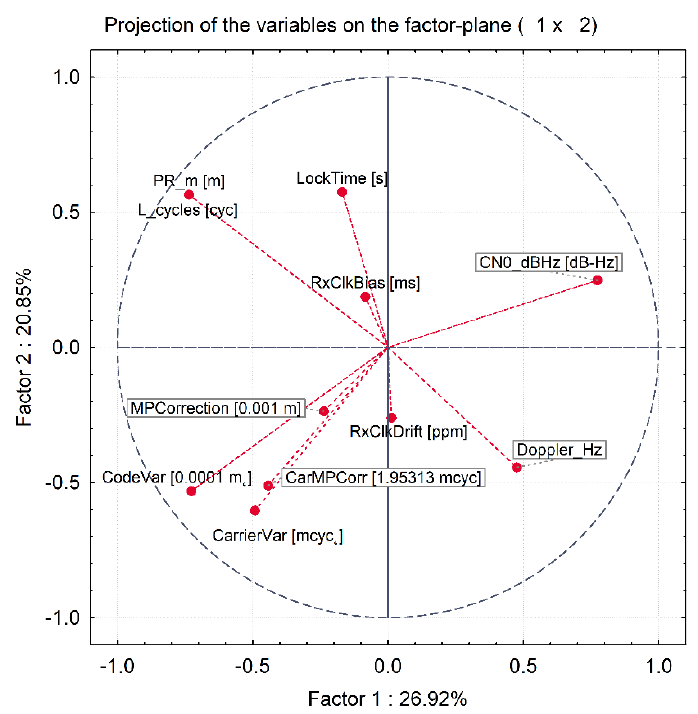
Figure 16. First two factors’ plot (adopted from [13]).